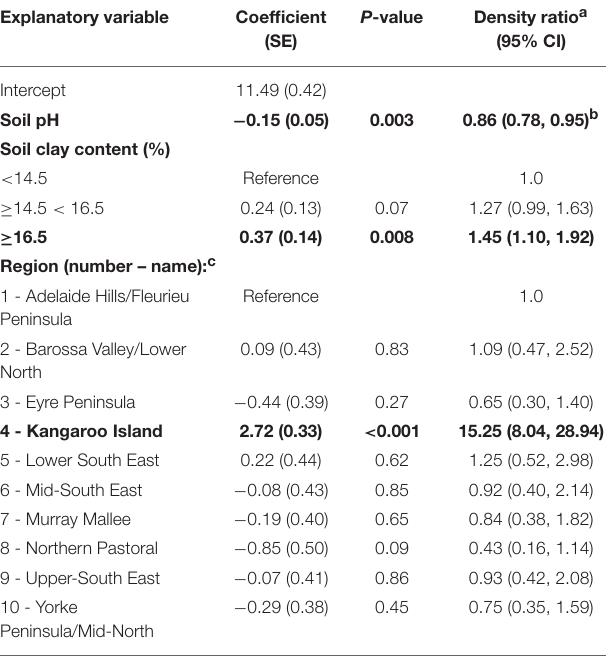
TABLE 3 | Estimated regression coefficients and their standard errors from the reduced Poisson point process model of variables associated with sarcocystosis-positive farm density.